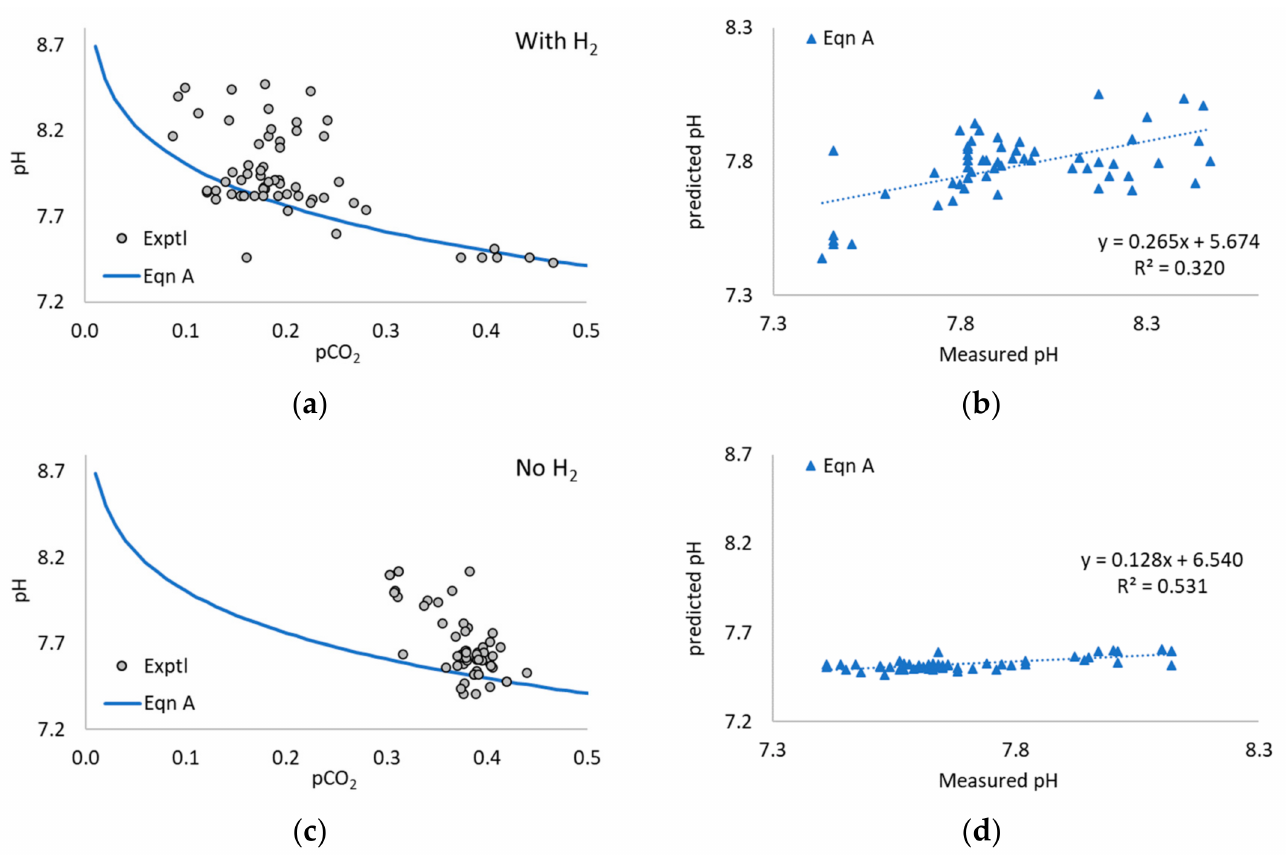
Figure A3. Experimental pCO 2 and pH values and predicted pH from Equation A for thermophilic UASB fed on potato starch wastewater with ( a , b ) and without ( c , d ) H 2 addition associated with Bassani et al. [53]. See Table S18 for operating conditions and average results for each phase.